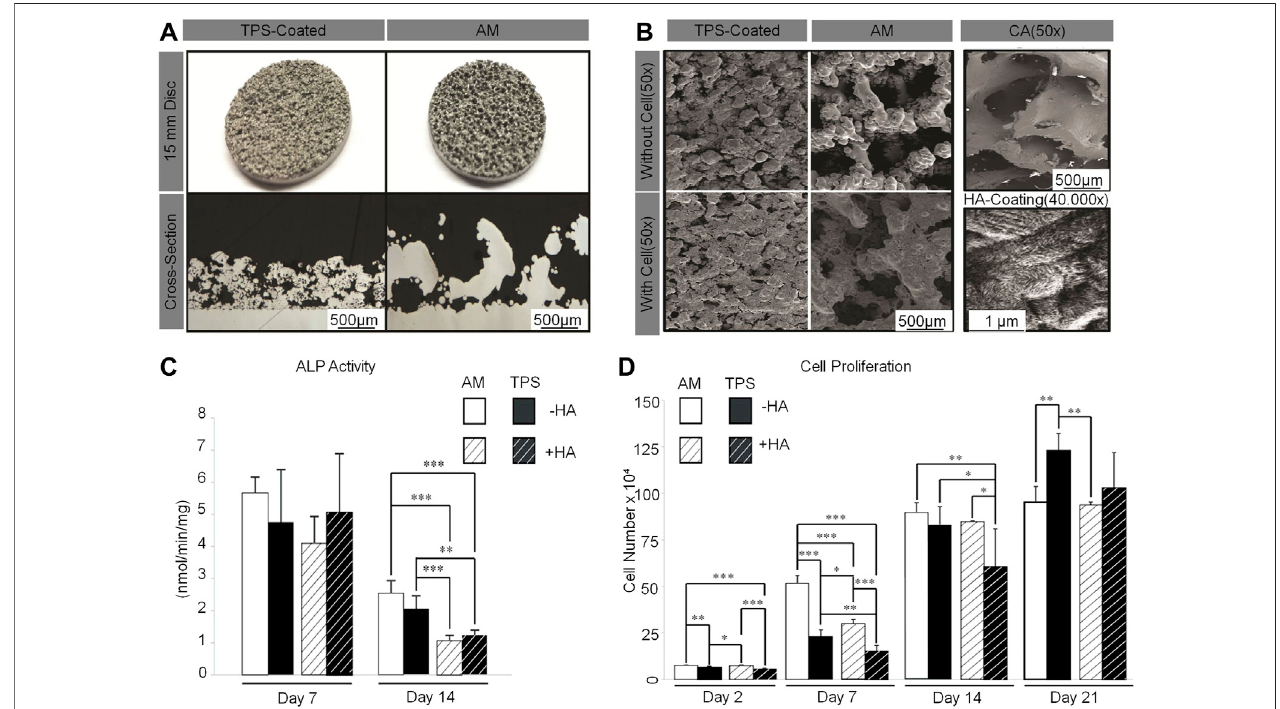
FIGURE 7 | (A) Gross images of TPS-coated and additive-manufactured (AM) discs (top). Cross-section images taken from stereological analysis (bottom). (B) Representative scanning electron microscopy images ofunseeded TPS-coated and AM discs (top left). Discs after 3 weeks ofculture with human 1.19 fetal osteoblast- like (hFOB) cells (bottom left) and of human cancellous bone allograft to show the target surface topography (top right). Representative scanning electron microscopy images of nano-crystalline HA coating on an AM disc (bottom right). (C) Two-way analysis of variance of AM compared to TPS-coated discs with and without a nano-crystallineHAcoatingforalkalinephosphataseactivity. (D) Two-wayanalysisofvarianceofAMcomparedtoTPS-coateddiscswithandwithoutanano-crystalline HA coating for cell proliferation (MacBarb et al.,